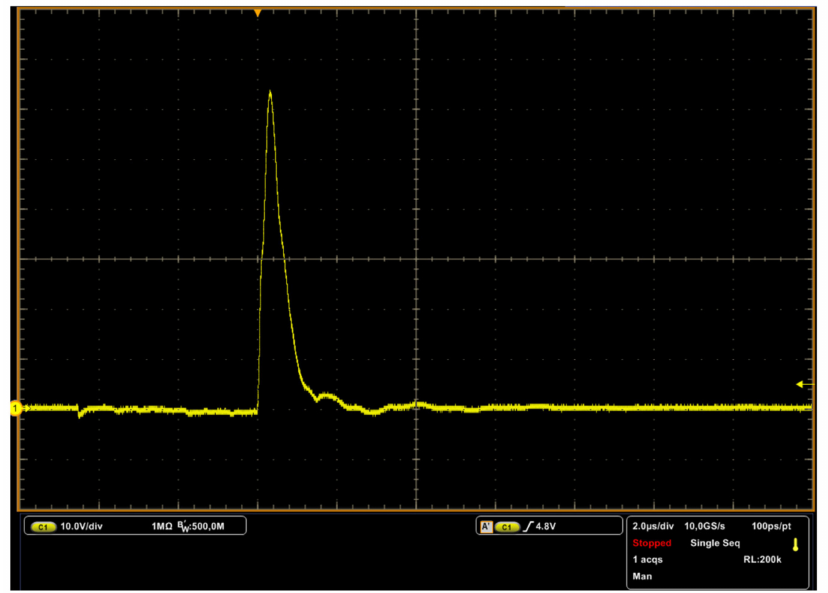
Figure 6. Characteristic oscillogram of reverse discharge current developing from the model antenna under radome (shunt 0.5 Ohm).